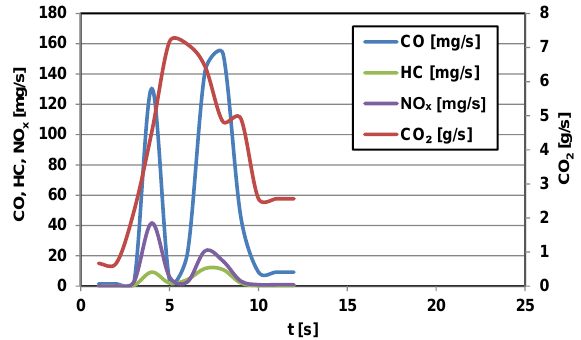
Fig. 11. Emission rates of individual exhaust gas components as a function of simulation time for: a = 2.5 m/s 2